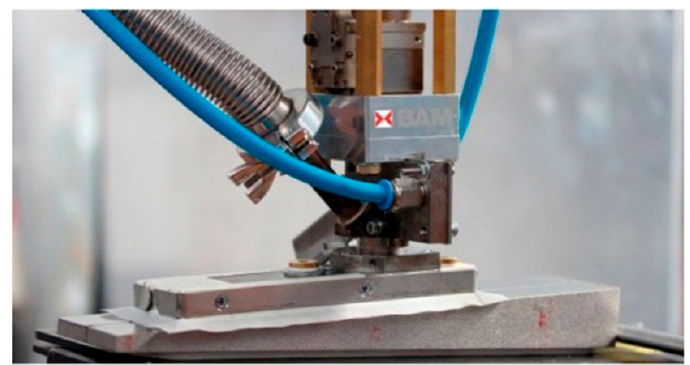
Figure 13. The mobile local vacuum chamber for high power laser beam welding of thick materials. Reproduced with permission from [66], John Willey and Sons, 2015.